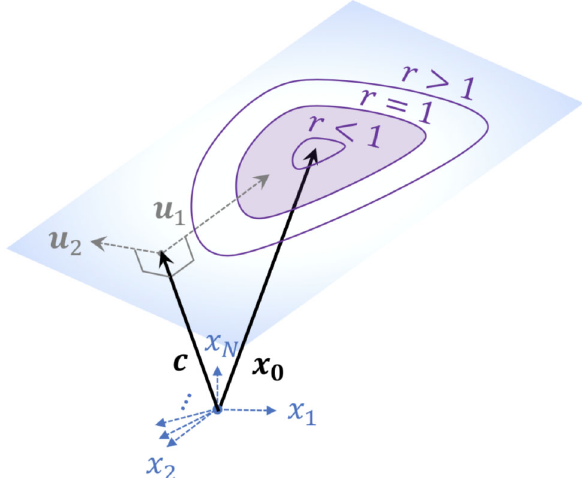
FIG. 2. Model of manifolds in affine subspaces. D ¼ 2 mani- fold embedded in R N . c is the orthogonal translation vector for the affine space, and x 0 is the center of the manifold. As the scale r is varied, the manifold shrinks to the point x 0 or expands to fill the entire affine